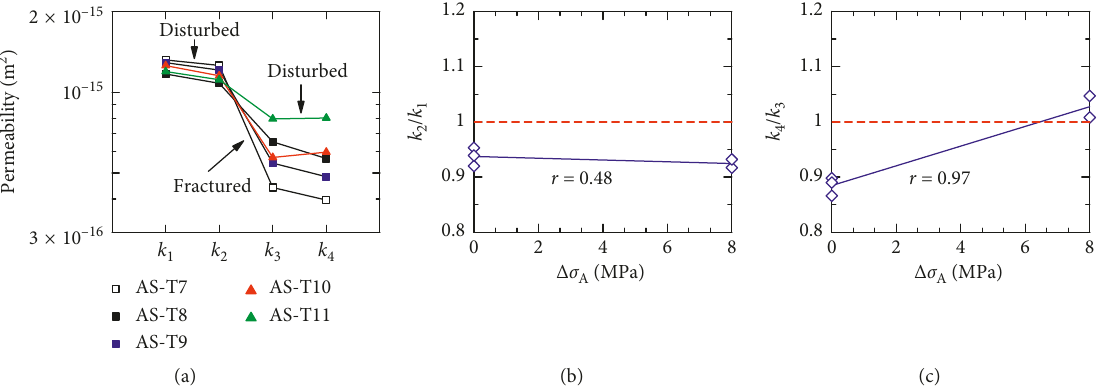
Figure 18: Variation in permeability (a), and permeability ratios of the intact rocks (b) and fractured rocks (c) ( P transient axial stress disturbances and the triaxial compression of the Shikotsu welded